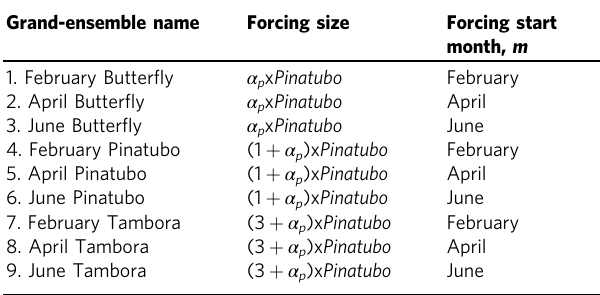
Each grand-ensemble involves 10 ICs forced with the sets of 10 perturbed forcings. Pinatubo corresponds to the original Pinatubo forcing, α p <0.01 is a Butter fl y forcing coef fi cient, p ranges from 1 to